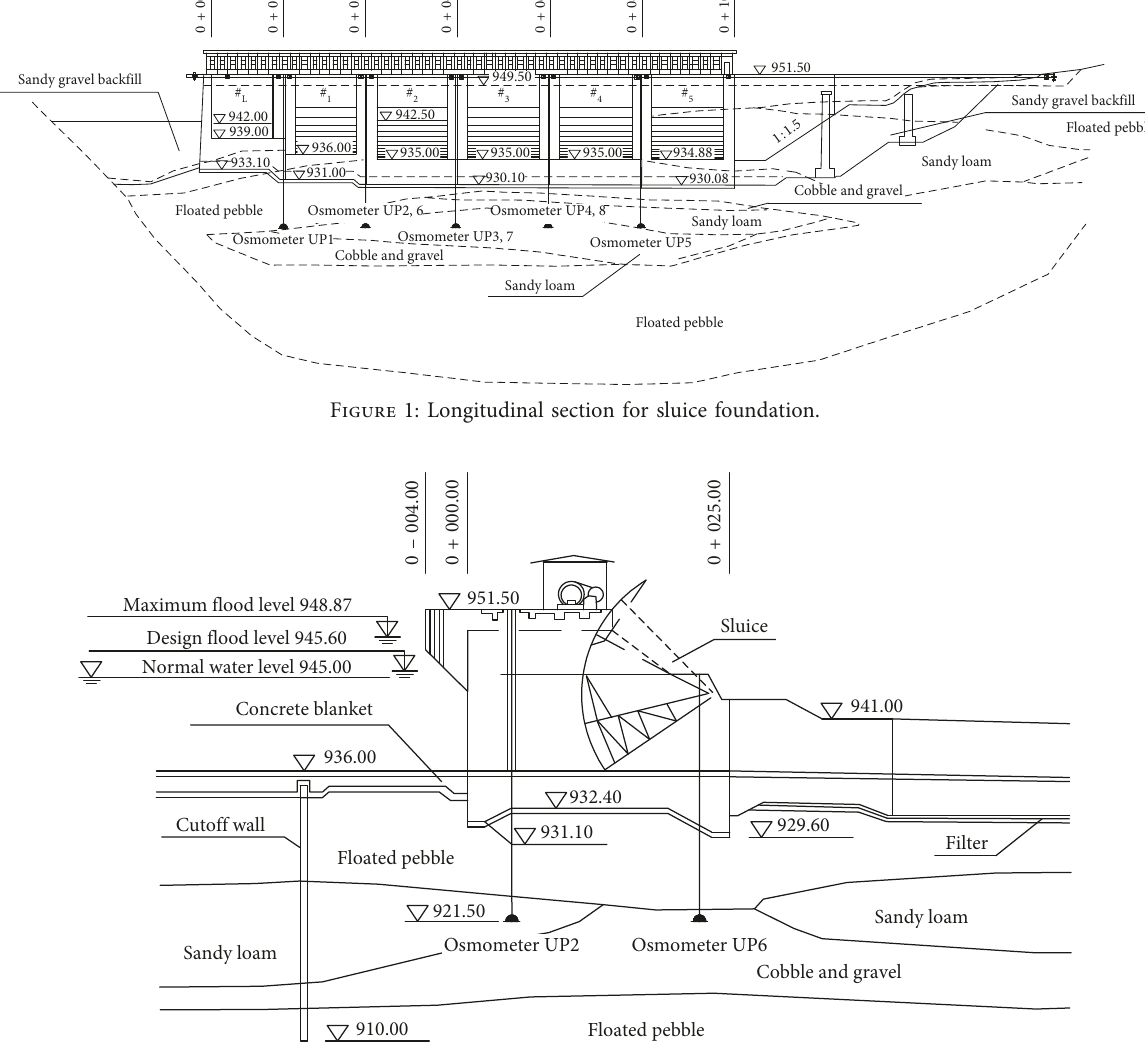
Figure 2: Cross section for 1# sluice